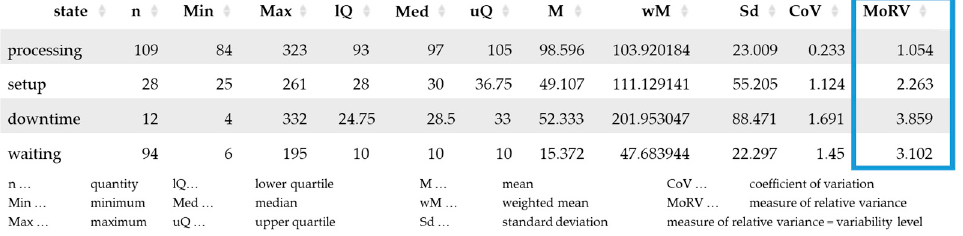
Figure 13. Example of the results of test series one, wherein the variability levels are marked in color.